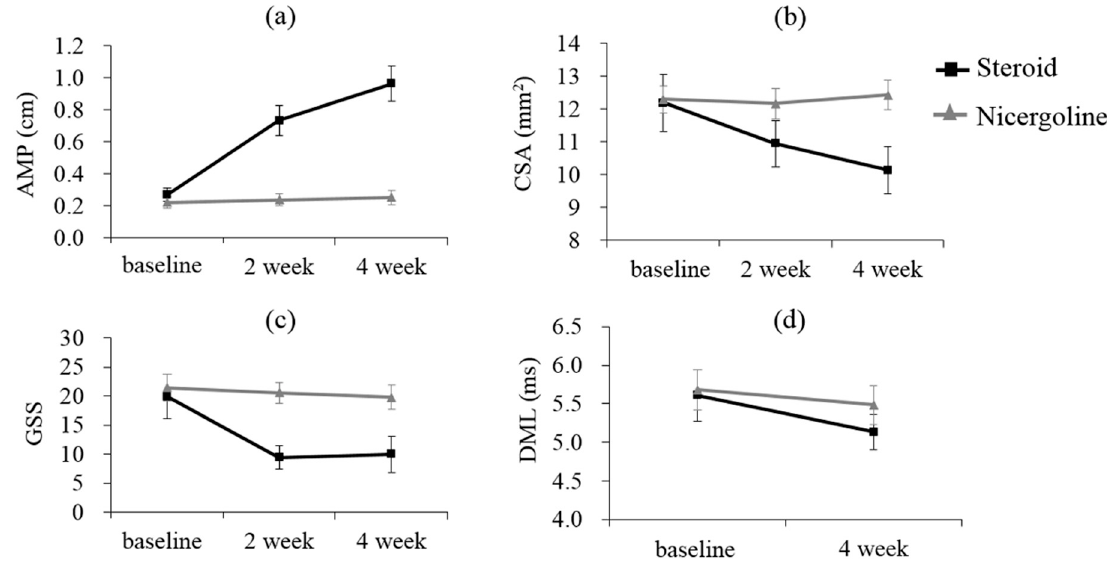
Figure 3. Changes in the least squares means over time in ( a ) amplitude, ( b ) cross-sectional area, ( c ) global symptom score, and ( d ) distal motor latency. Table 2. Least squares means of AMP, CSA, GSS, and DML at the 1st (baseline), 2nd, and 4th week with a mixed-effects model *.